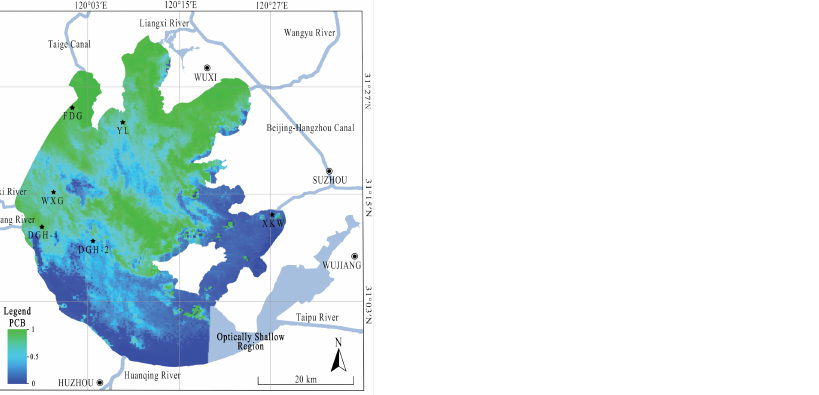
Figure 1. Study area and sampling sites in Lake Taihu, China. The black stars ( (cid:70) ) represent the sample sites. Color pattern represents distribution of proportion of cyanobacterial biomass (PCB) in Lake Taihu on 18 May 2017, which were referred to by Miao et al.